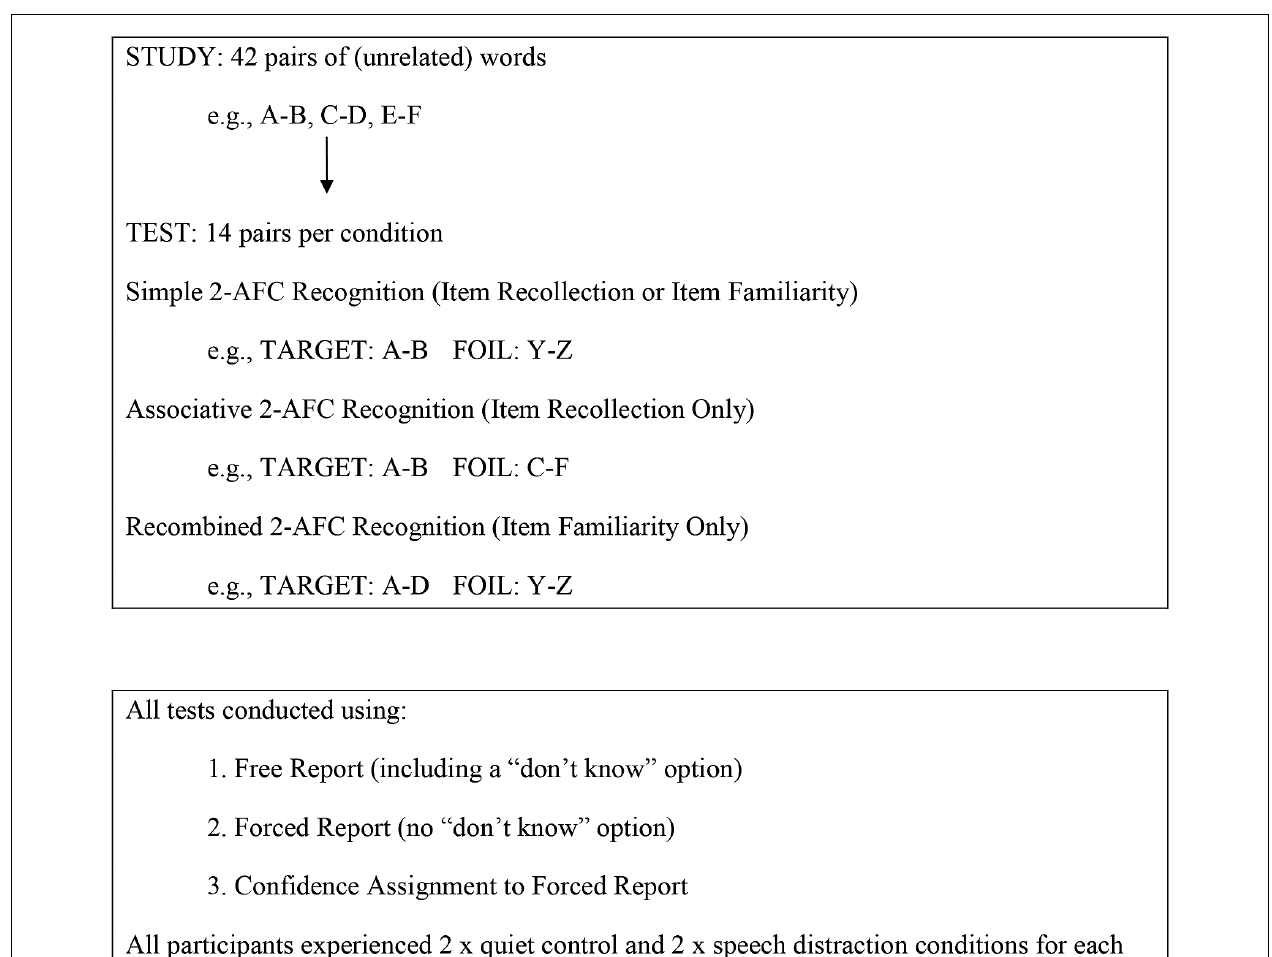
FIGURE 2 | Representation of the experimental design.